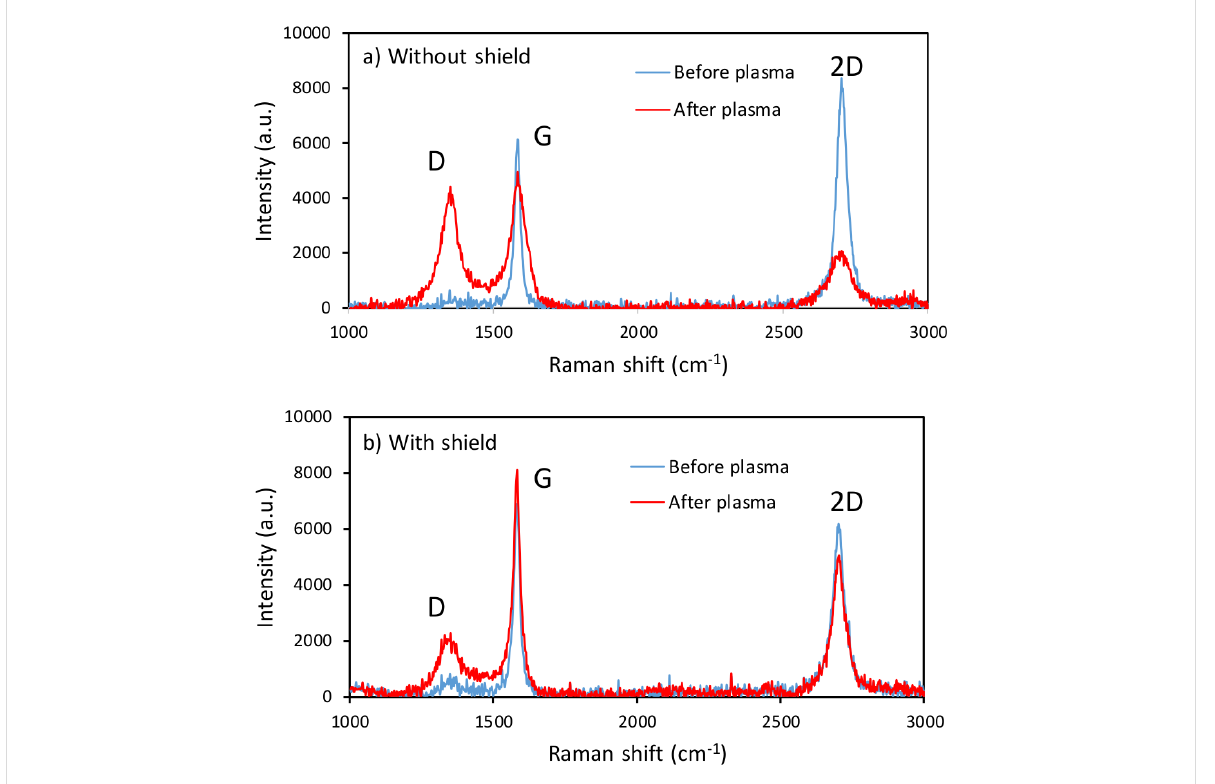
Figure 4: Raman spectra of samples of graphene grown on resonators before and after the O 2 plasma treatment a) without and b) with glass shield. Note the degradation of the graphene layer when immersed in plasma without shield.